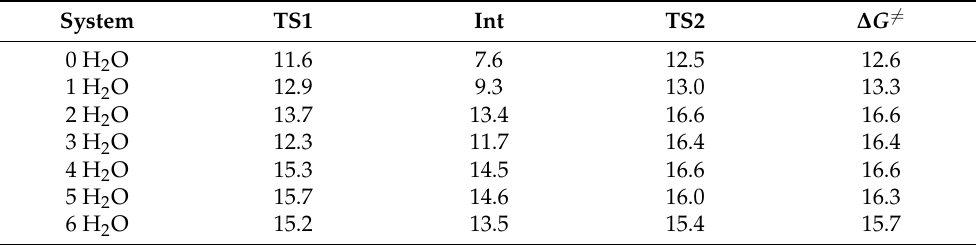
Figure 1. Comparison of the results of the B AC 2 reaction path of CBL without microsolvation and with 1–6 H 2 O molecules. Free energies of TS1, Int, TS2, and P are relative to the R of each pathway. Table 1. Relative free energies and the corresponding activation free energies ( ∆ G (cid:54) = ) of the B AC 2 reaction path of CBL with 0–6 H 2 O molecules. Free energies of TS1, Int, and TS2 are relative to the R of each pathway. Energies are presented in